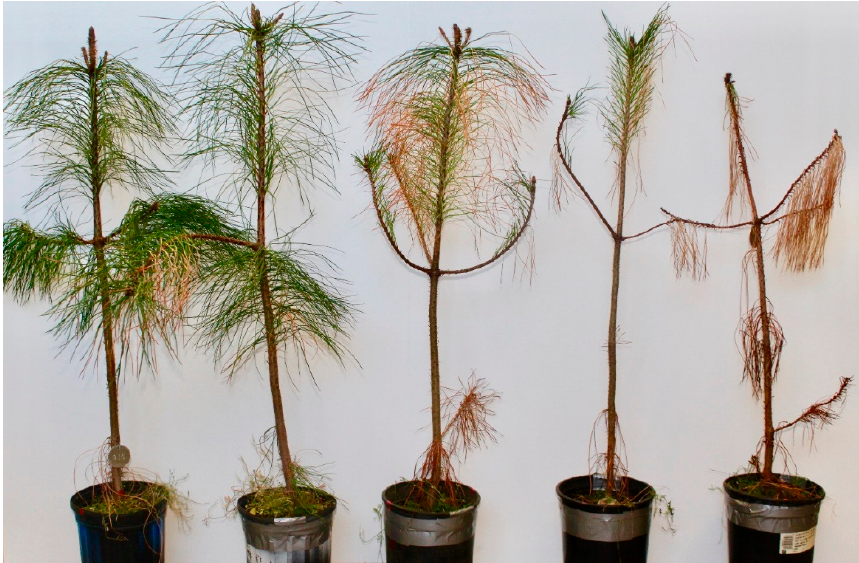
Figure 2. Representative examples of the health of the Pinus ponderosa saplings at the end of the experiment. From left to right, saplings represent the unburned control and treatments of 0.2 MJ m − 2 , 0.4 MJ m − 2 , 0.6 MJ m − 2 , and 0.8 MJ m − 2 . A clear visual dose-response is apparent, with the degree of surface charring and crown scorch increasing with increasing FRE dosages.